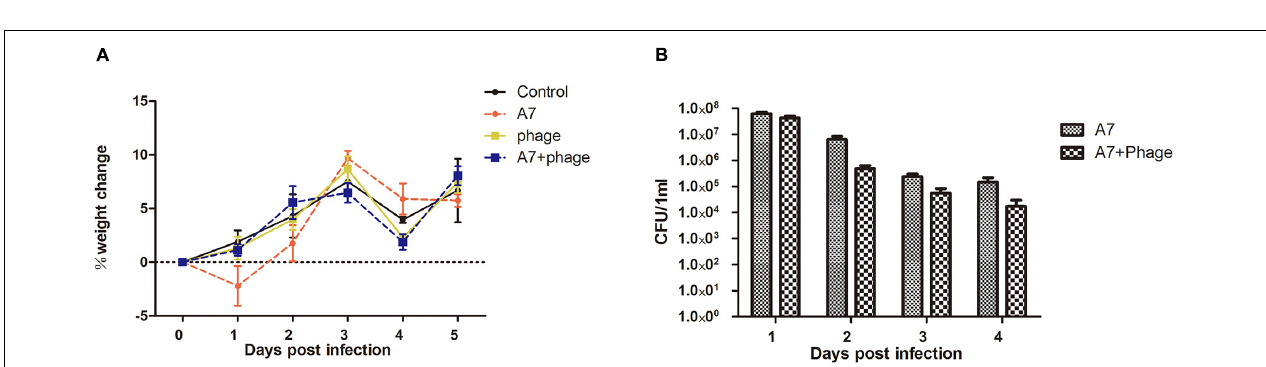
FIGURE 8 | Inhibitory effect of phage vB_ShiP-A7 on Shiglla flexneri A7 infection in mice. (A) Changes of body weight of mice in different treatment groups, Control (control group), A7 ( Shiglla flexneri A7infection group), phage (phagevB_ShiP-A7 group), and A7+phage ( Shiglla flexneri A7 infection plus phage vB_ShiP-A7 treatment group). (B) Killing effect of the phage on Shiglla flexneri A7 in mice at different days after infection, A7 ( Shiglla flexneri A7infection group) and A7+phage ( Shiglla flexneri A7 infection plus phage vB_ShiP-A7 treatment group).